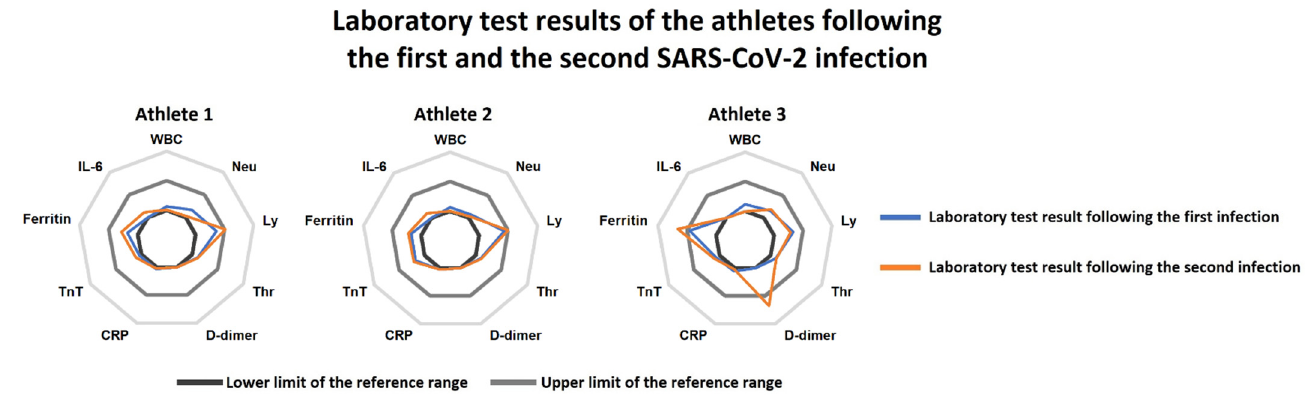
Figure 1. Radar charts of the laboratory tests following the first SARS-CoV-2 infection (blue line) and the reinfection (orange line) in the three athletes. Athletes 2 and 3 had practically no relevant alterations at the first and the second examinations. Athlete 1 presented with increased serum ferritin levels at the first examination, which persisted at the second return-to-play assessments as well. Moreover, mildly elevated D-dimer levels were also found at the second laboratory test in this subject.